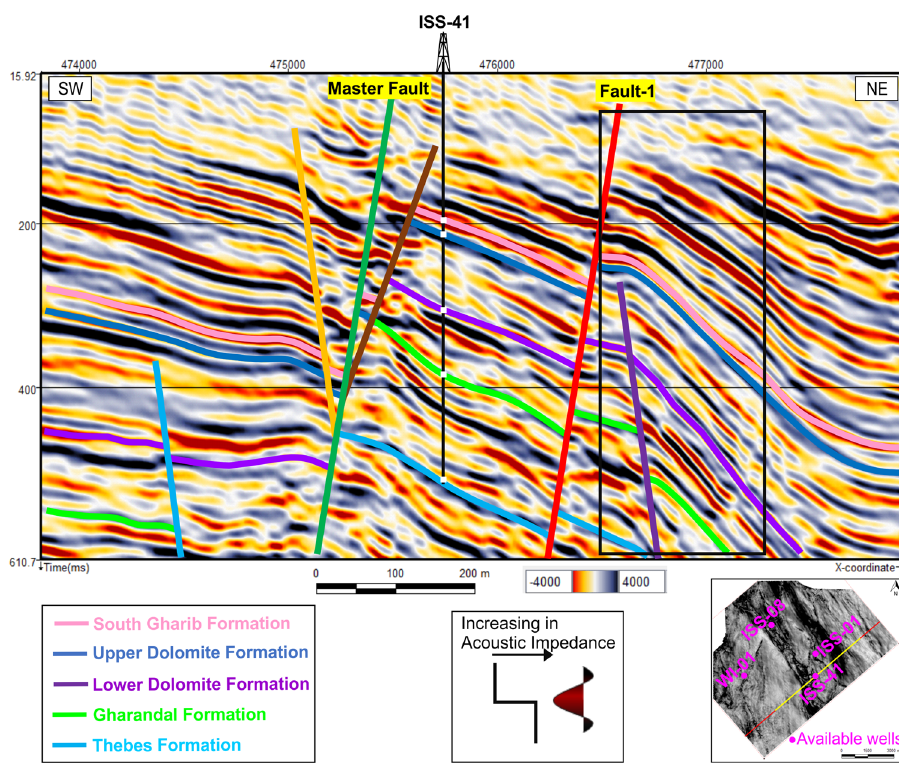
Fig. 9 The Seismic inline 11,825 dip section illustrates that the reflectors in the eastern part of the Issaran field are char- acterized by a higher tilting gra- dient (highlighted by the black rectangle) than the reflectors in the central and western